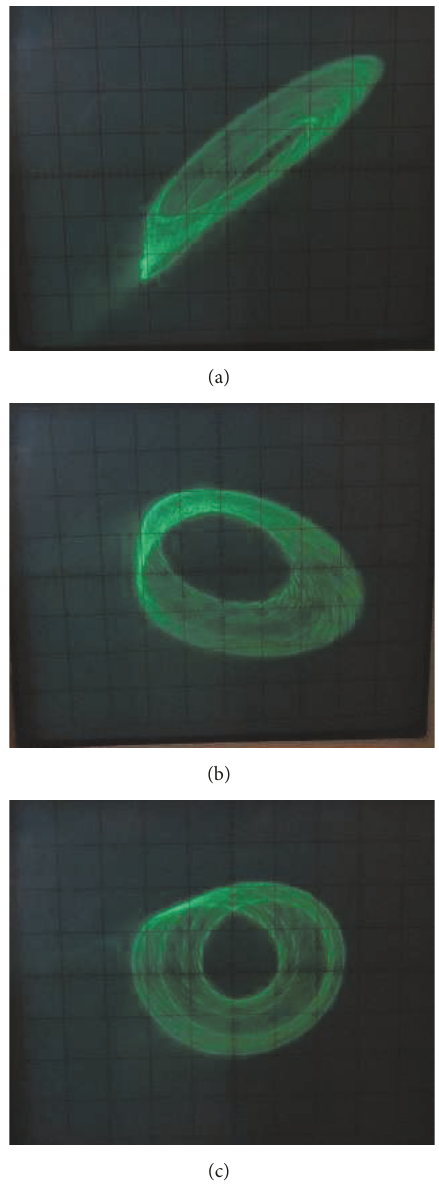
Figure 11: Experimental phase portraits of the real circuit in (a) ( 𝑉 𝑥 , 𝑉 𝑦 ) plane, (b) ( 𝑉 𝑥 , 𝑉 𝑧 ) plane, and (c) ( 𝑉 𝑦 , 𝑉 𝑧 ) plane with 𝑅 𝑎 = 1.47 k Ω , 𝑅 = 2.5 k Ω , and 𝑅 = 10 k Ω 𝑏 𝑐